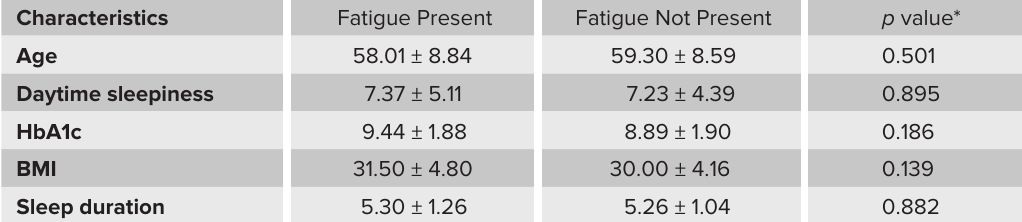
Table 3: T-Test Comparing Diabetic Patients with and Without